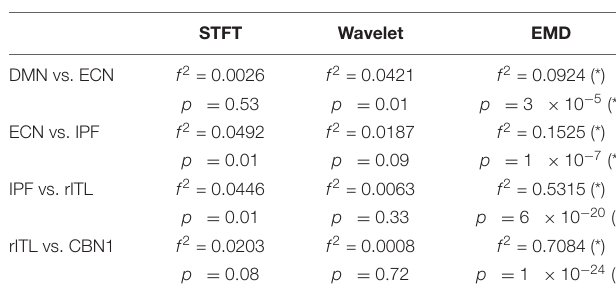
TABLE 2 | Cohen’s effect size and p value for pairwise comparison of log T k for the different resting-state networks in Figures 5 , 7 .